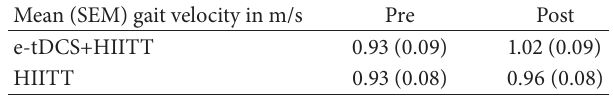
Table 3: Overground fast walking